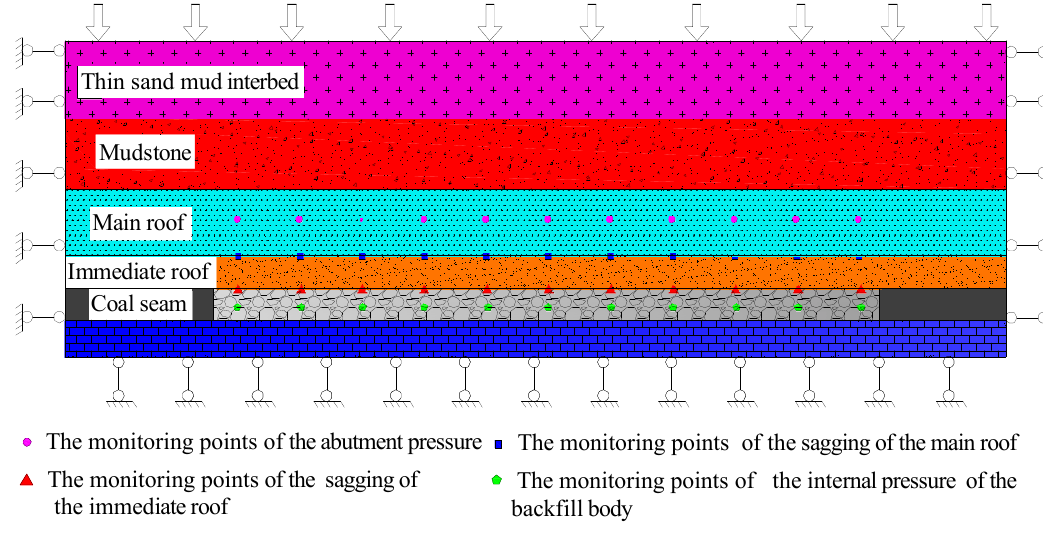
Figure 8. Monitoring points in the profile numerical model.